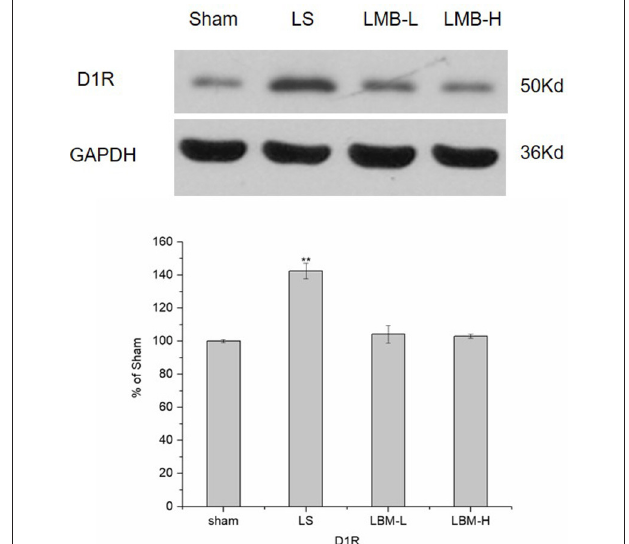
FIGURE 3 | Changes in expression of membrane-D1R extracted from the rat’s ipsilateral striatum after 21 days of administration. The expression of membrane-D1R in the LS group was significantly higher than that in the LBM group (LBM-L and LBM-H) and sham group ( p < 0.01). There was no difference among the LBM-L, LBM-H, and the sham group. The membrane-D1R levels expressed relative to GAPDH levels. The data are expressed in terms of means ± SD and expressed as a percentage of the sham group. ** p < 0.01 vs. sham group ( n = 3 per